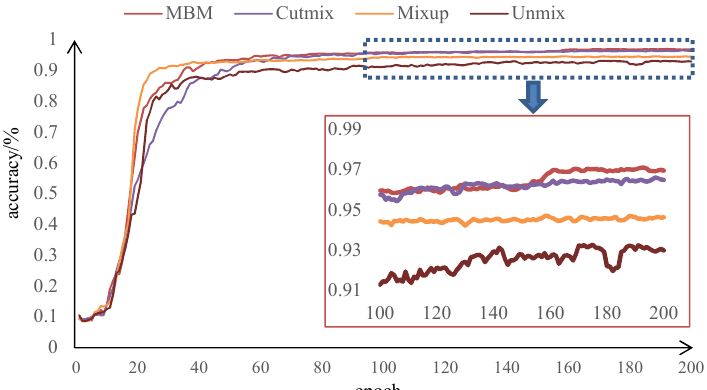
Figure 8. Recognition accuracy curves of the MBM, cutmix, mixup, and unmixed methods under 10 labeled samples per